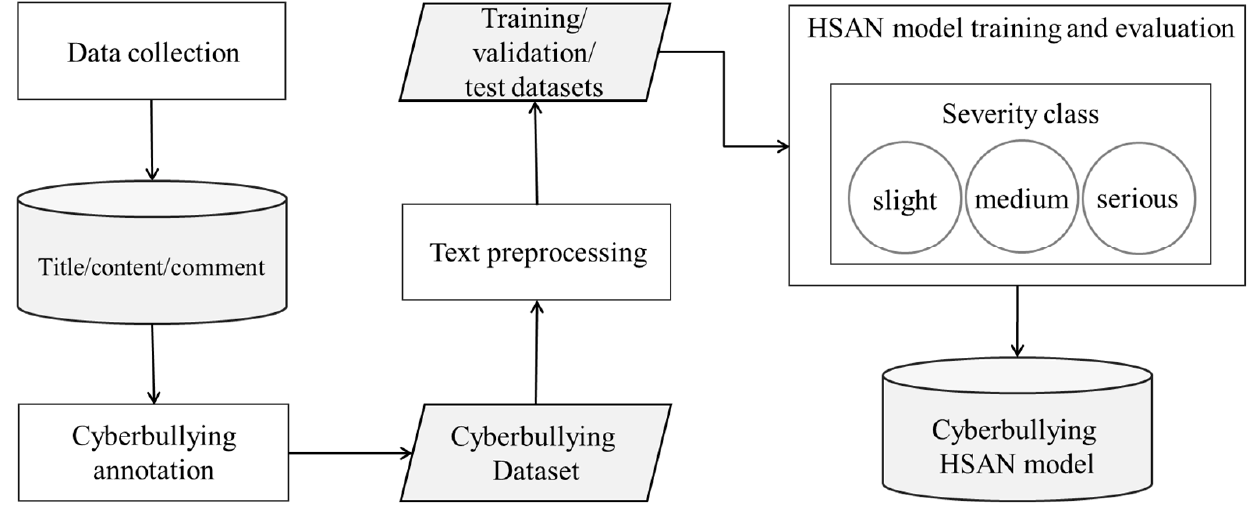
Figure 2. Flowchart of the proposed HSAN method for cyberbullying severity classification.